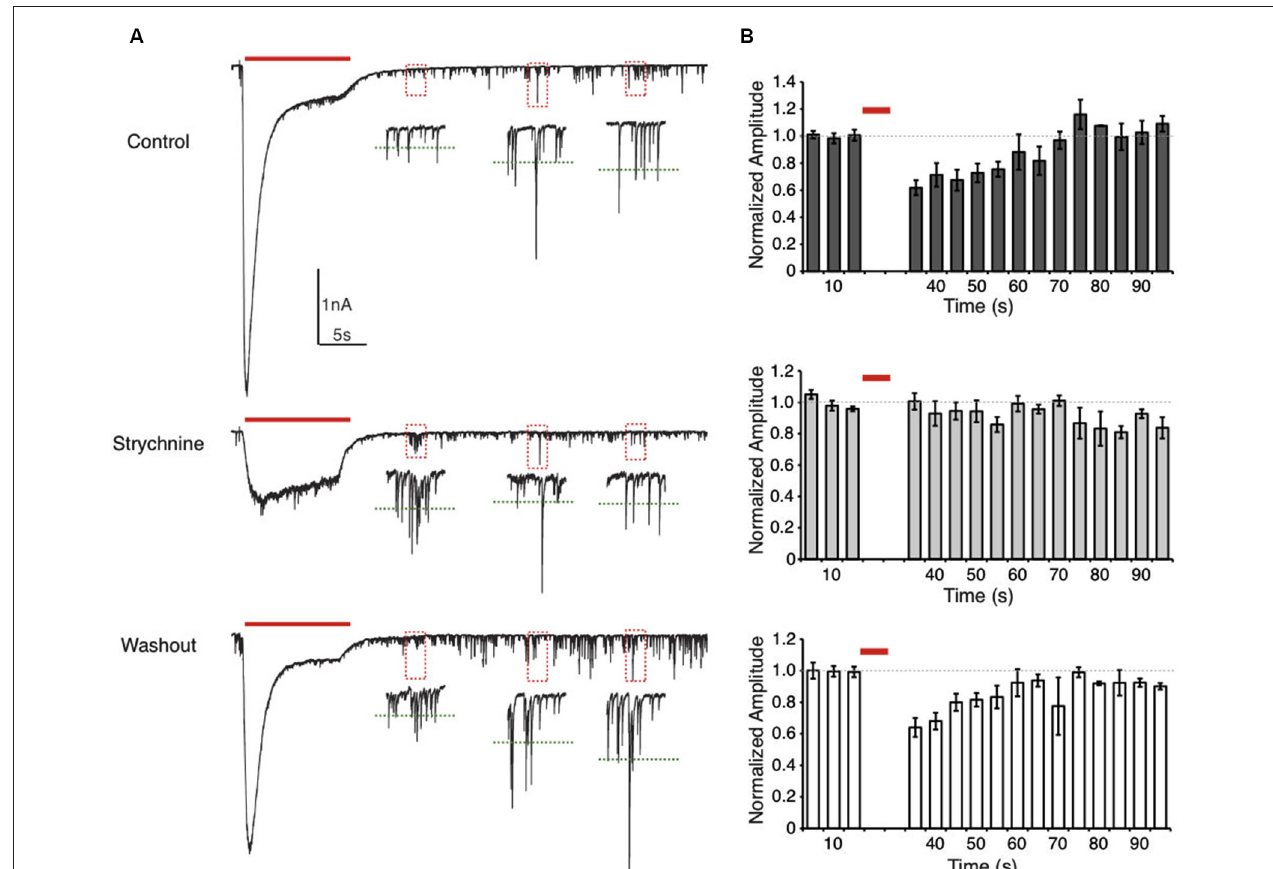
(strychnine) but recovered after washout. Note that in the strychnine condition the GlyR block was often incomplete, but the large onset current was eliminated. (B) Histograms representing the normalized population data for the sIPSC amplitude analysis. Dashed line represents the average sIPSC amplitude before the glycine application. Each bin represents the average sIPSC amplitude during a 5 s time window. In the control and washout condition, sIPSC amplitude recovered to baseline values after approximately 35